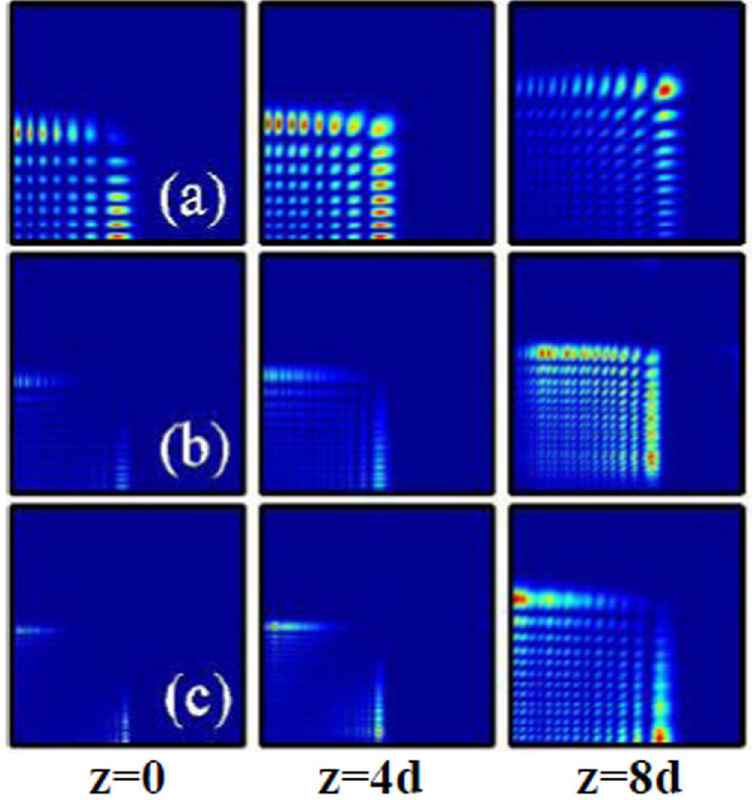
Figure 3. The intensity distributions of a vortex Airy beam at different propagation distances in local self- focusing nonlinear media ( σ = 0). The initial parameters are x 0 = y 0 = 0, A = 2 ( a ), A = 0.2 ( b ), and A = 0.01 ( c ). The topological charges are m = 1 ( a ), m = 2 ( b ), and m = 3 ( c ),